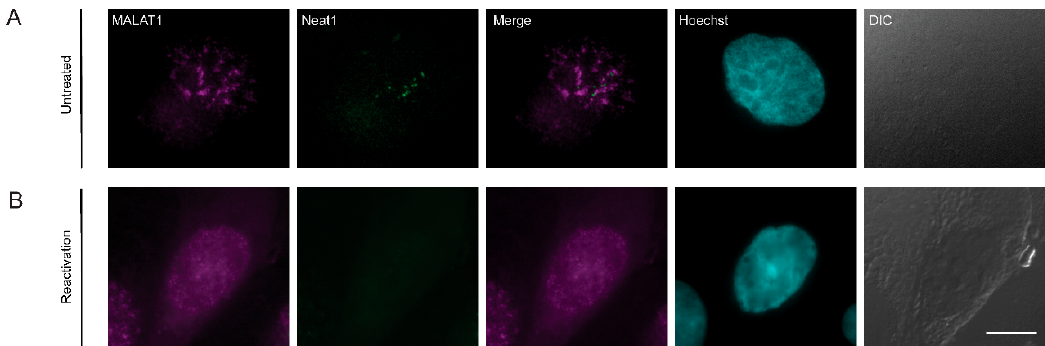
Figure 8. The distribution of lncRNAs during lytic reactivation of KSHV infection. MALAT1 (magenta) and Neat1 (green) lncRNAs were detected by RNA FISH in ( A ) untreated cells and ( B ) BAC16-infected iSLK cells that were treated to induce the lytic cycle of KSHV infection for 48 h. Hoechst in cyan; DIC in grey. Bar, 10 μ m.